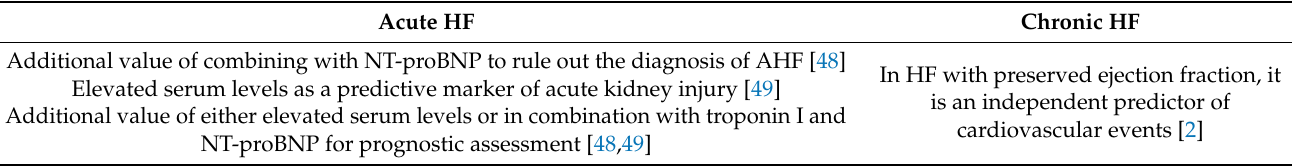
Table 2. Clinical application of the assessment of H-FABP in HF. Acute HF Chronic HF Additional value of combining with NT-proBNP to rule out the diagnosis of AHF [48] In HF with preserved ejection fraction, it Elevated serum levels as a predictive marker of acute kidney injury [49] is an independent predictor Additional value of either elevated serum levels or in combination with troponin I and NT-proBNP for prognostic assessment [48,49]